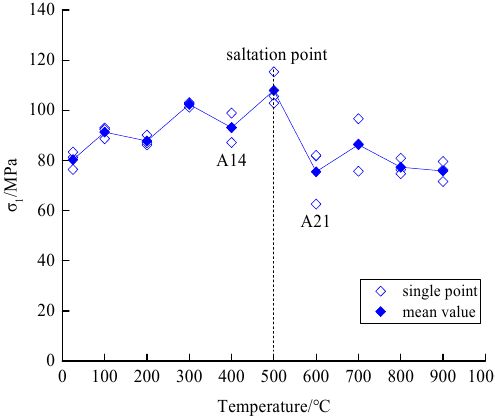
Figure 10. Relationship between uniaxial compressive strength and temperature.